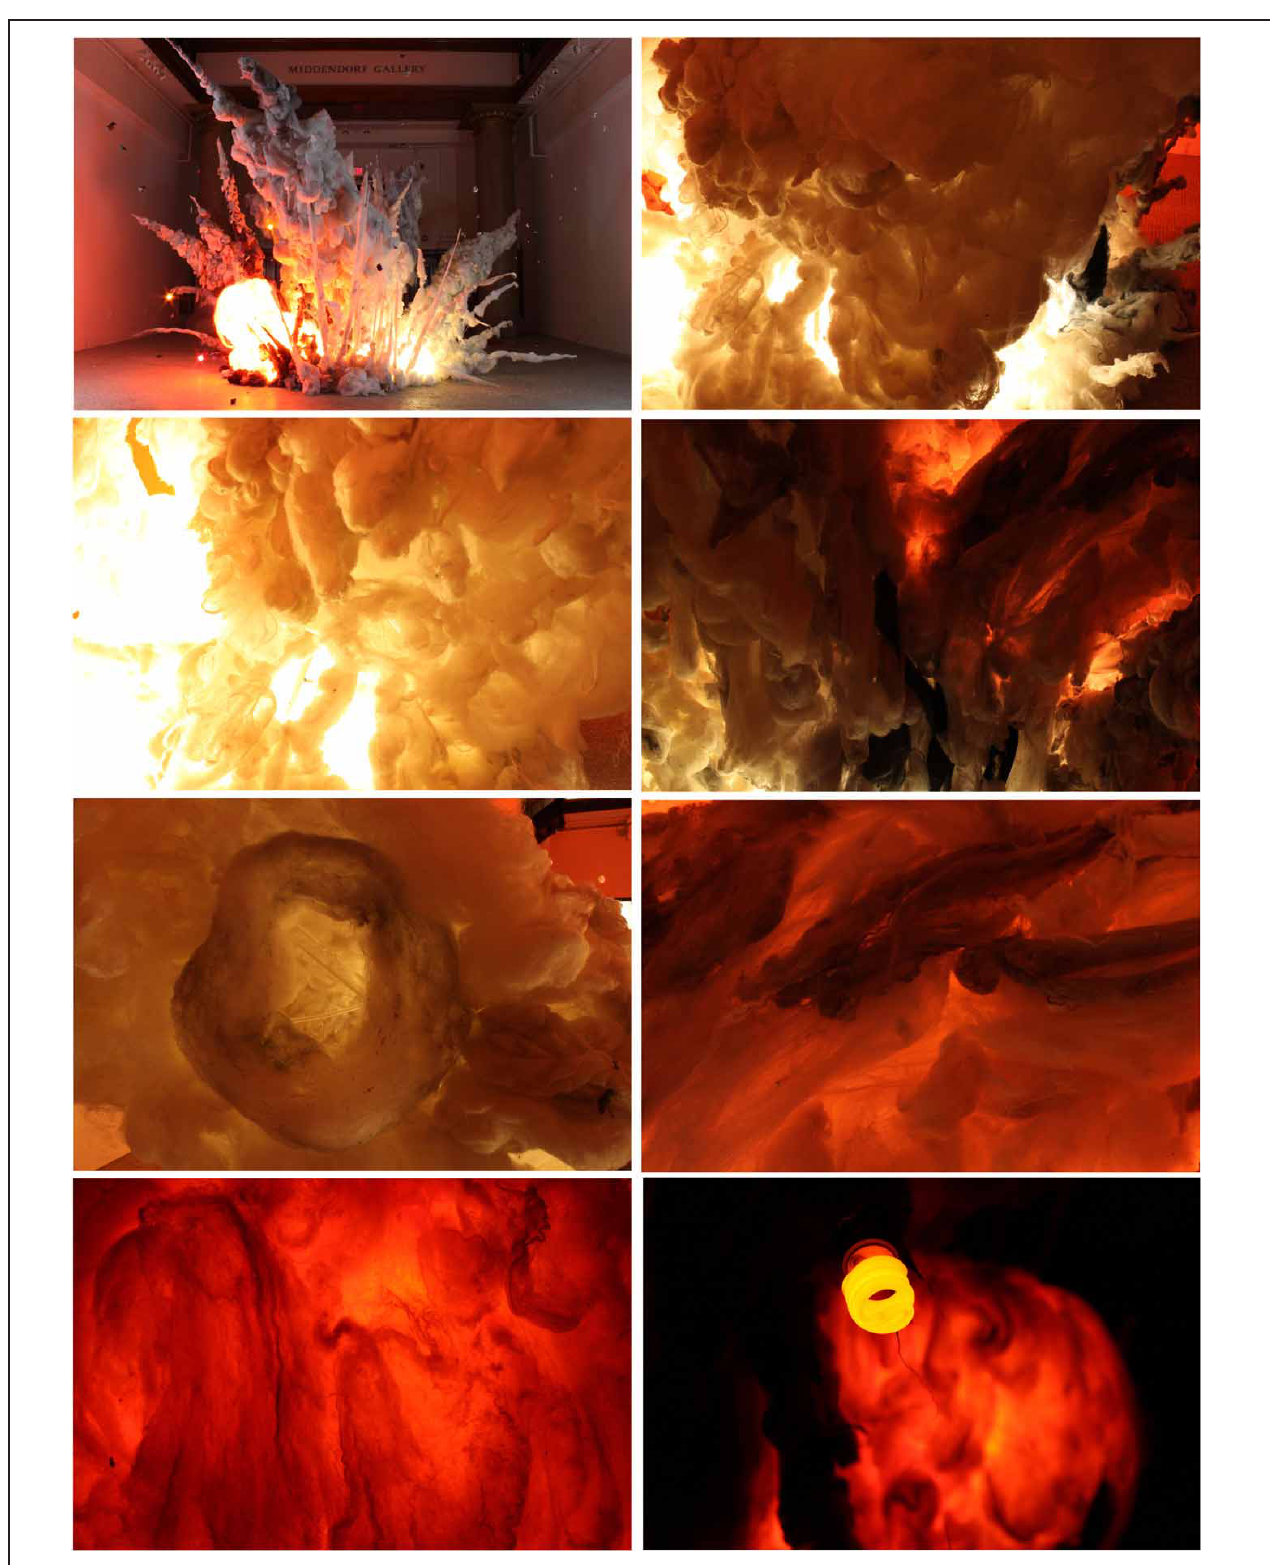
FIGURE 5 | Details of the “Silk explosion or how to destroy 10 6 cocoons that will never become butterflies” (2011). Silk, MDF, electrical conduit, CFL ligthbulbs, plexiglass, shrink fast plastic. 6 × 6 × 3m. Middendorf Gallery (Baltimore).